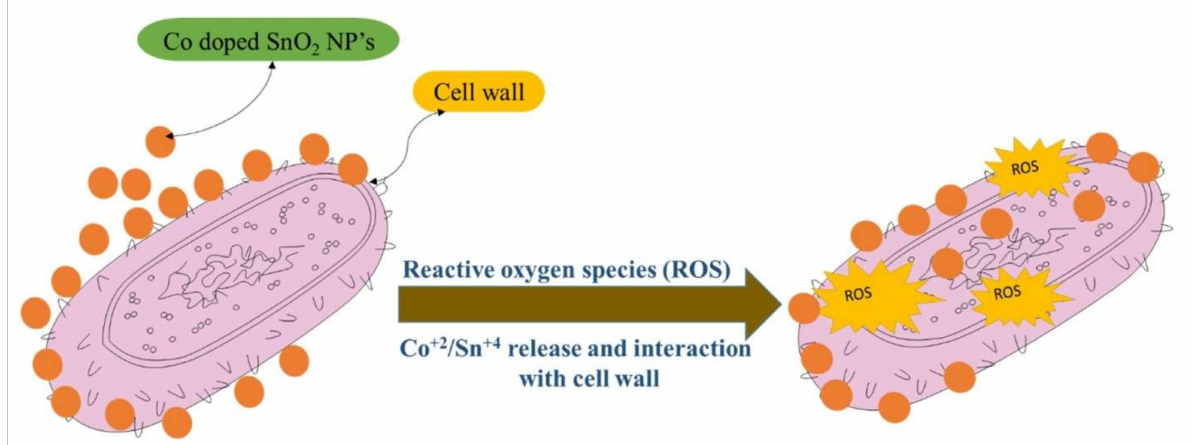
Figure 15. Schematic diagram of the antibacterial activity from generation of ROS induced by Co-doped SnO 2 NPs. Figure reprinted from Reference [152]. Copyright 2017